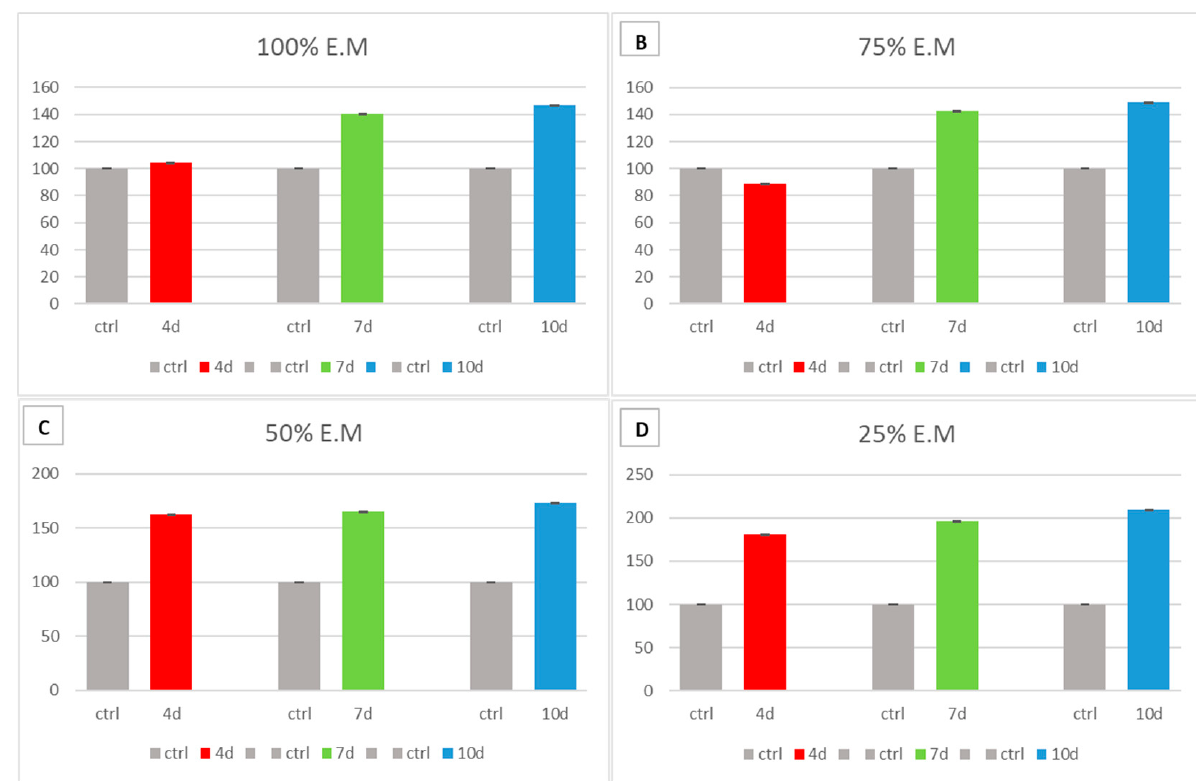
Figure 4. Figure 4 shows the MTT vitality assay. The cytotoxicity of the exhausted medium collected at 4 (red bars), 7 (green bars) and 10 (blue bars) days was evaluated in hADSCs in the presence of different concentrations MCF-7—Exhausted Medium (100% MCF-7—Exhausted Medium ( A ), 75% MCF-7 E.M ( B ), 50% MCF-7 E.M ( C ), and 25% MCF-7 E.M ( D )). Cell viability was compared to untreated controls hADSCs cultured in the presence of the basic growing medium alone (grey bars) and expressed as absorbance at 570 nm. The experiments were performed with three technical replicates for each treatment. Data are expressed as mean ± SD referred to the